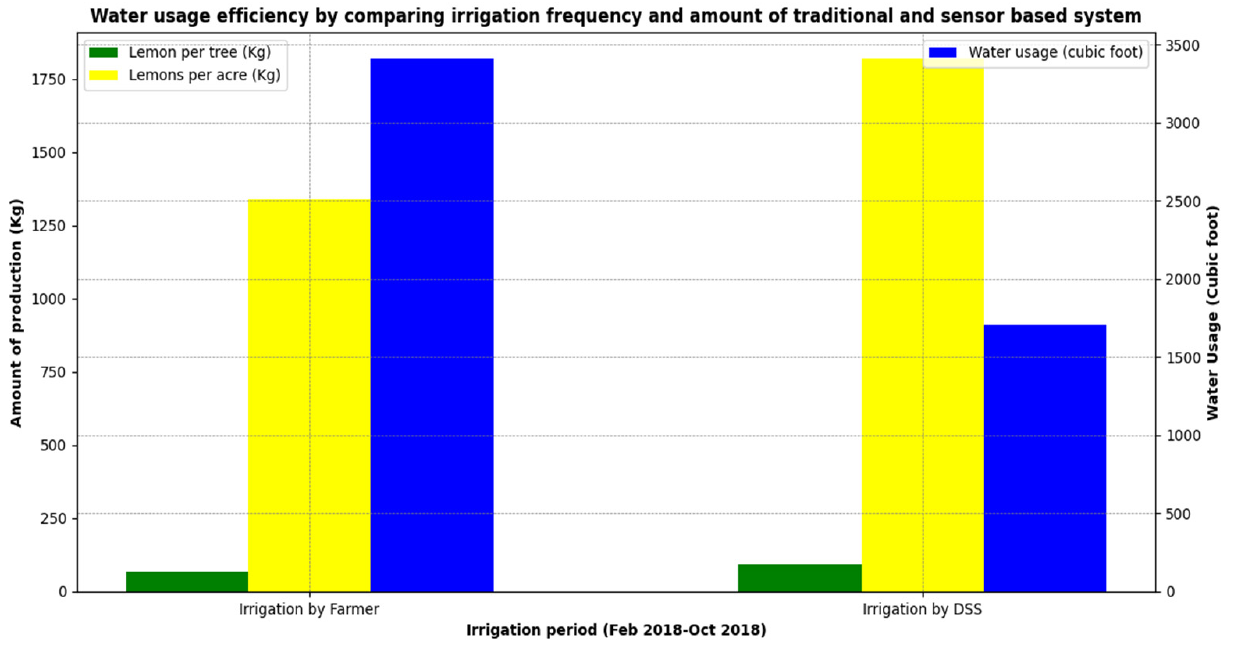
Figure 9. Yield increase for lemon crop.